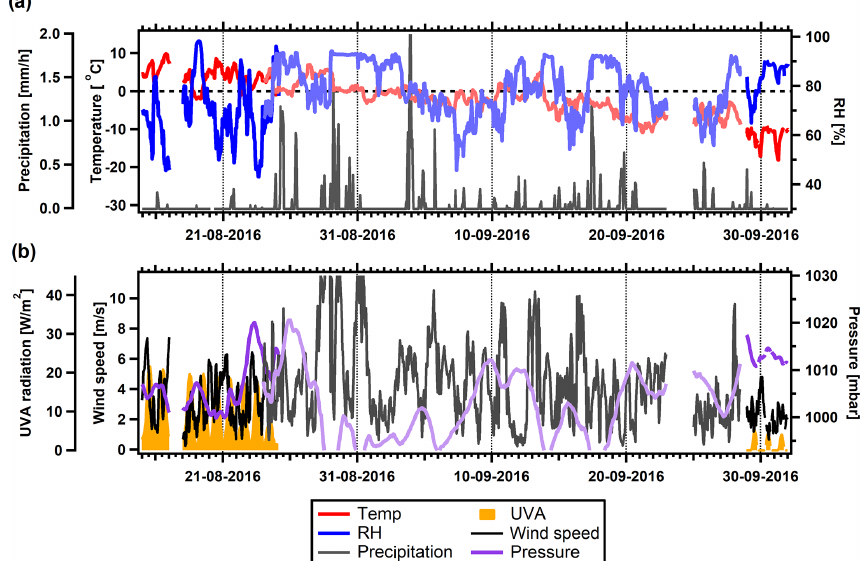
Figure 3. Overview of meteorological conditions during the summer field study. Lighter shaded lines are backup measurements. (a) Tem- perature, RH, and precipitation. The dashed line indicates 0 ◦ C. (b) UVA radiation, wind speed, and atmospheric